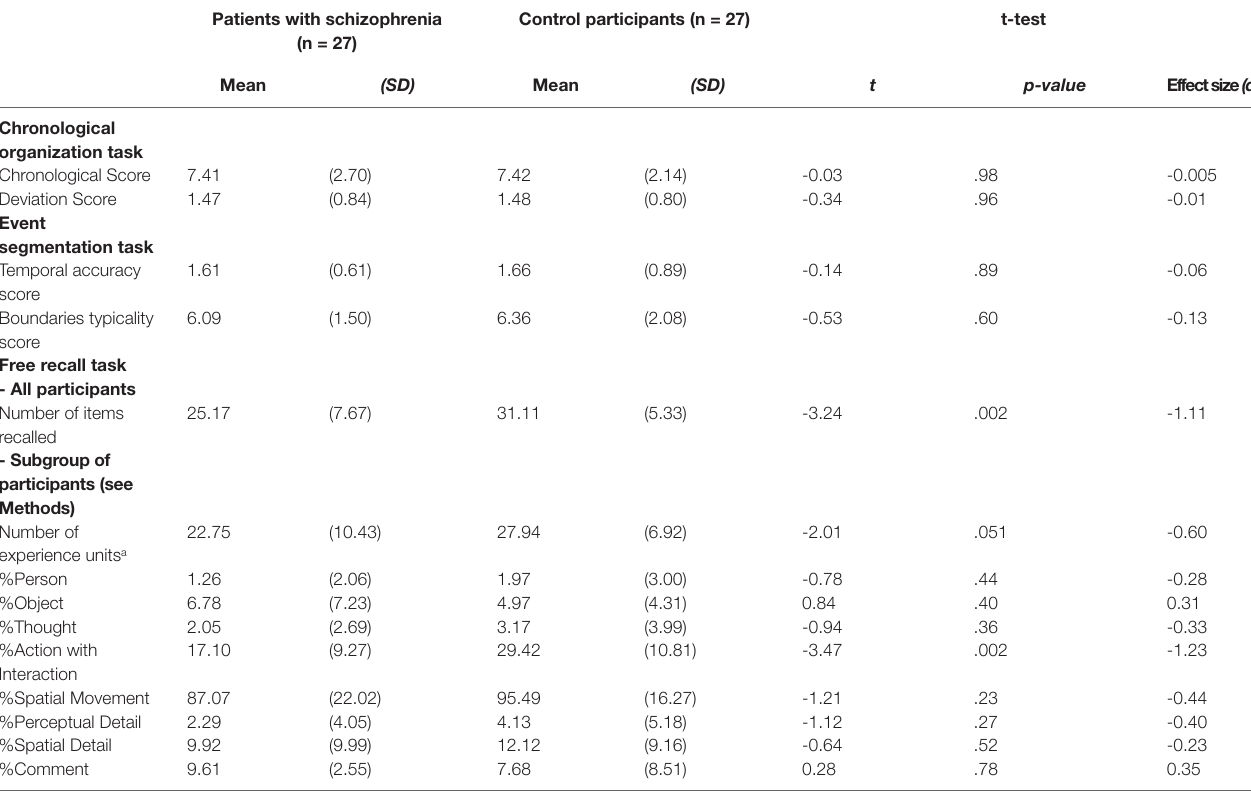
TABLE 3 | Mean scores of patients with schizophrenia and control participants for autobiographical memory